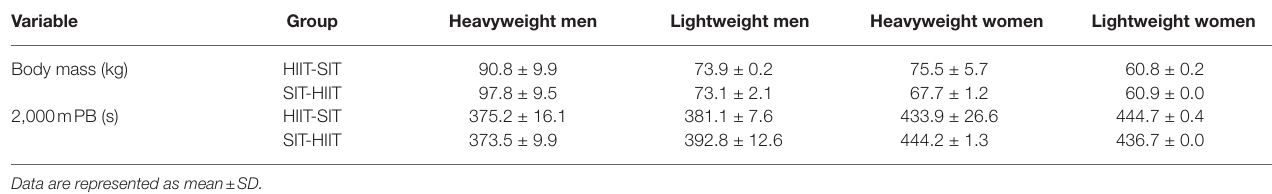
TABLE 1 | Mean body mass and 2,000 m rowing ergometer PB for heavyweight and lightweight athletes in HIIT-SIT and SIT-HIIT groups. Variable